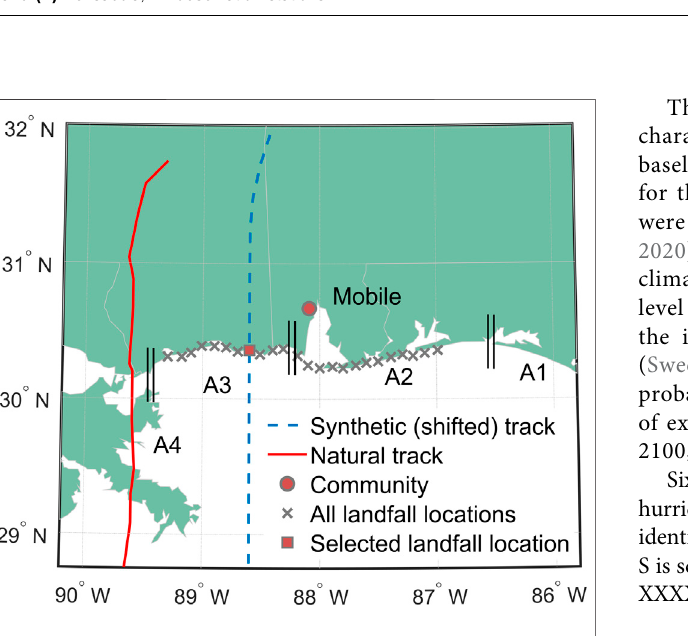
FIGURE 11 | The landfall locations and hurricane